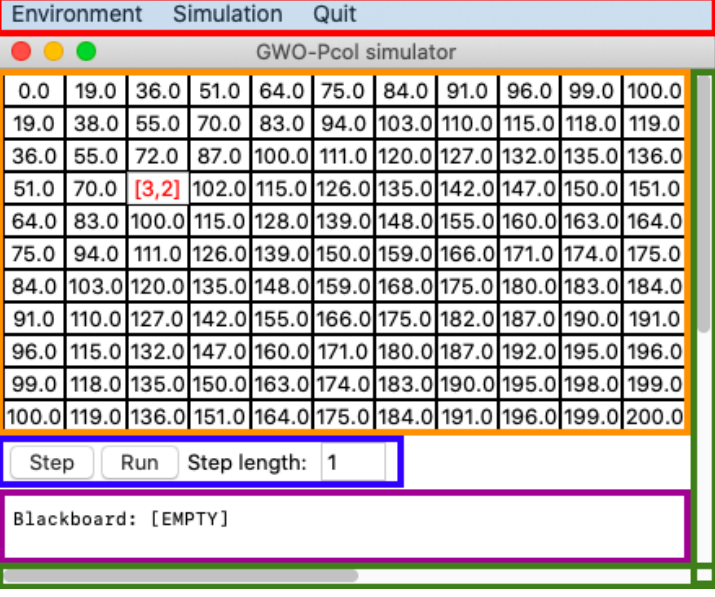
Figure 9. Graphic User Interface